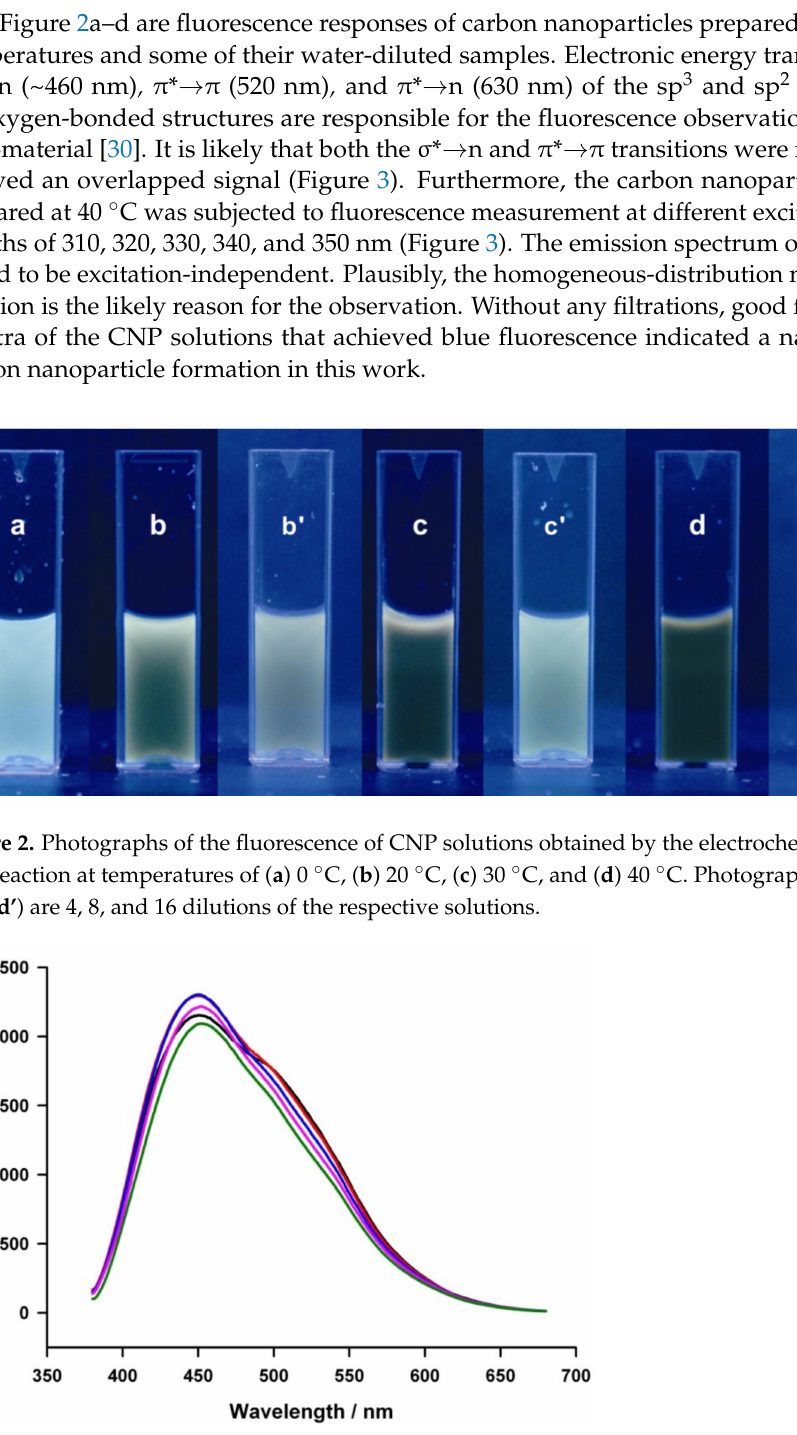
Figure 3. Emission spectra of CNP solutions (40 ◦ C Preparation) at different excitation wavelengths of 310 nm (black line), 320 nm (red line), 330 nm (blue line), 340 nm (pink line), and 350 nm (green line),